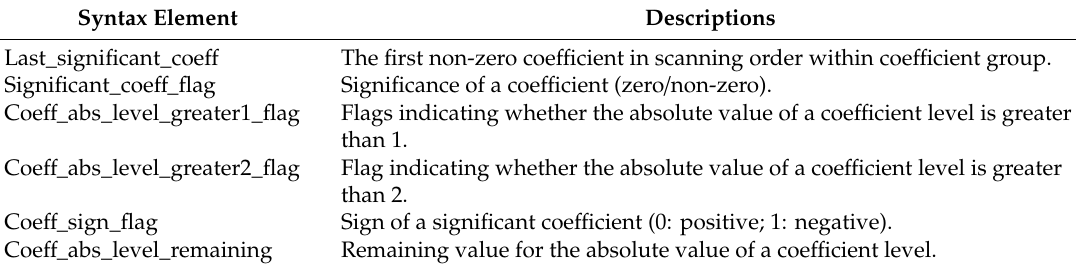
Table 2. Syntax elements of 4 × 4 residual transform data.